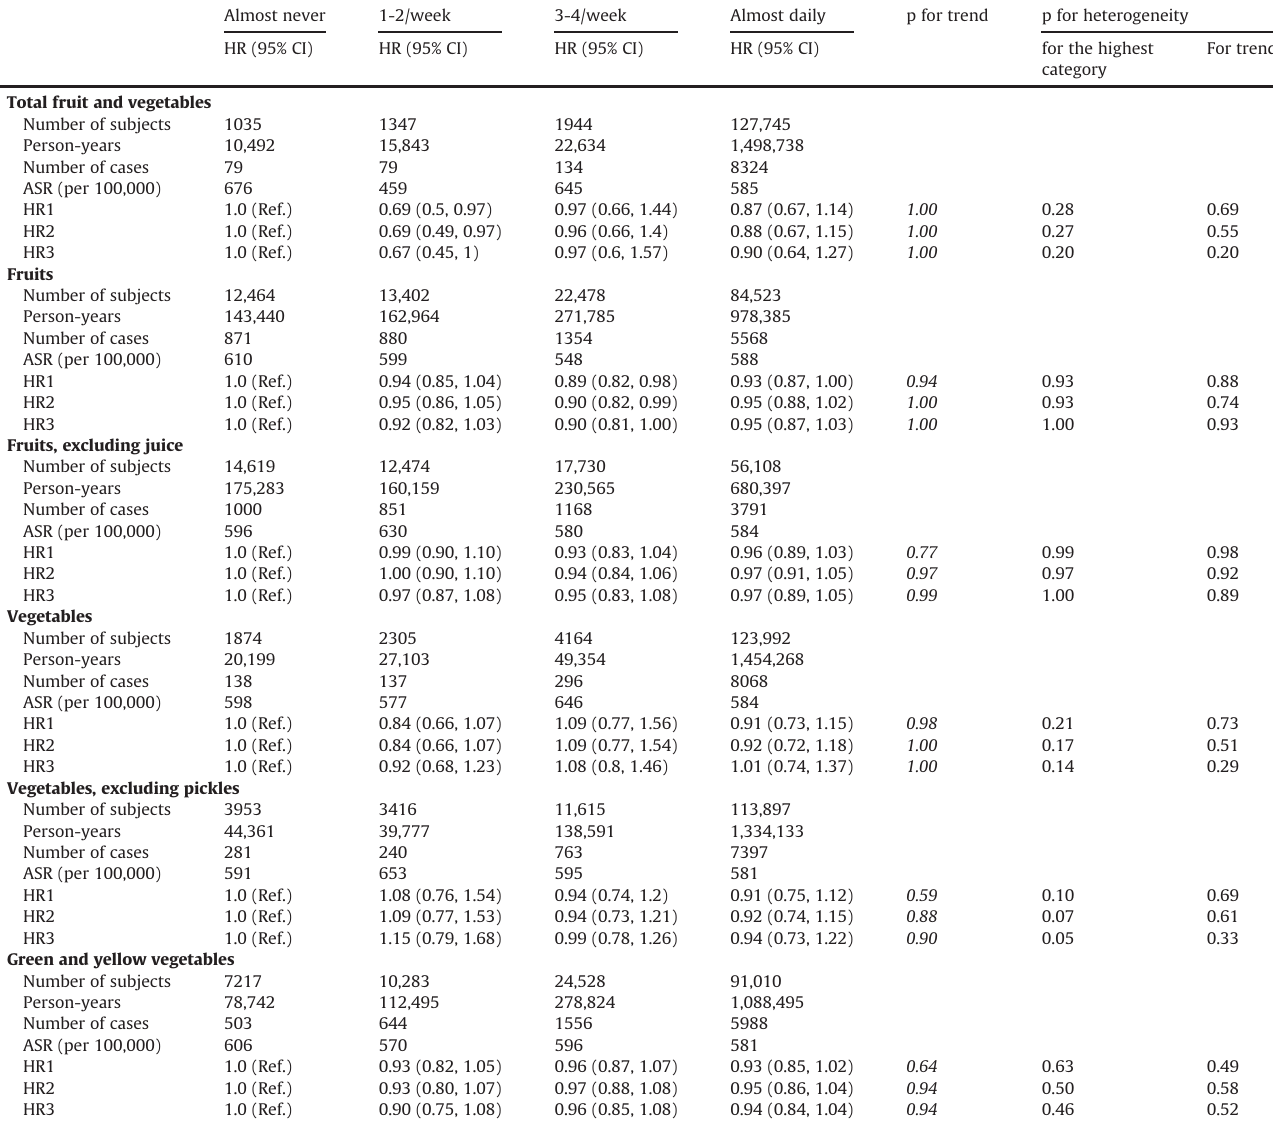
Table 5-2 Pooled analysis of total cancer incidence according to frequency of fruit and vegetable intake among 133,350 Japanese women,1990 e 2006. Almost never 1-2/week 3-4/week Almost